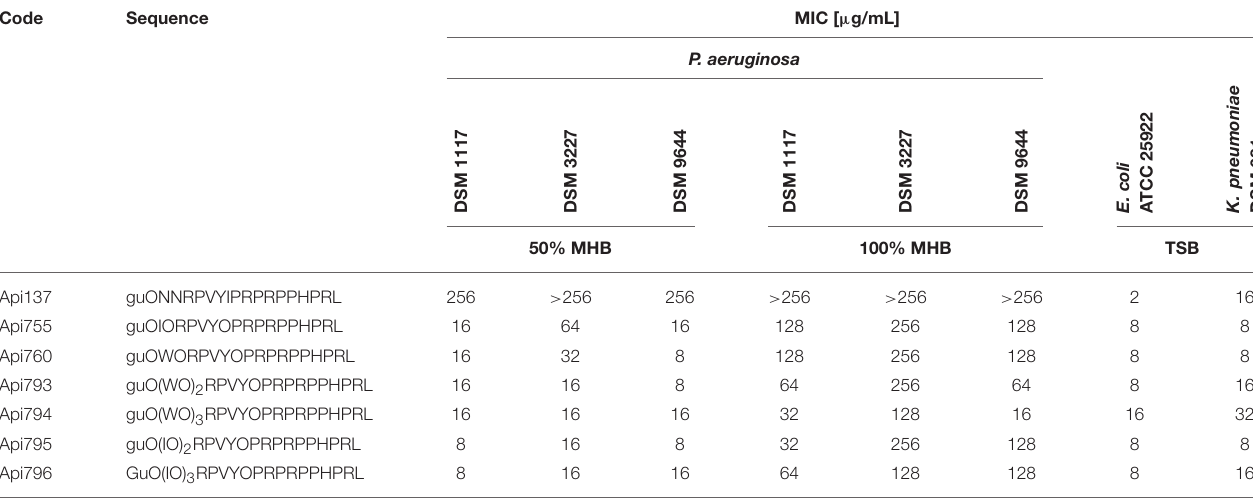
TABLE 1 | Peptide sequences and minimal inhibitory concentrations (MICs) of Api137 and its new analogs.